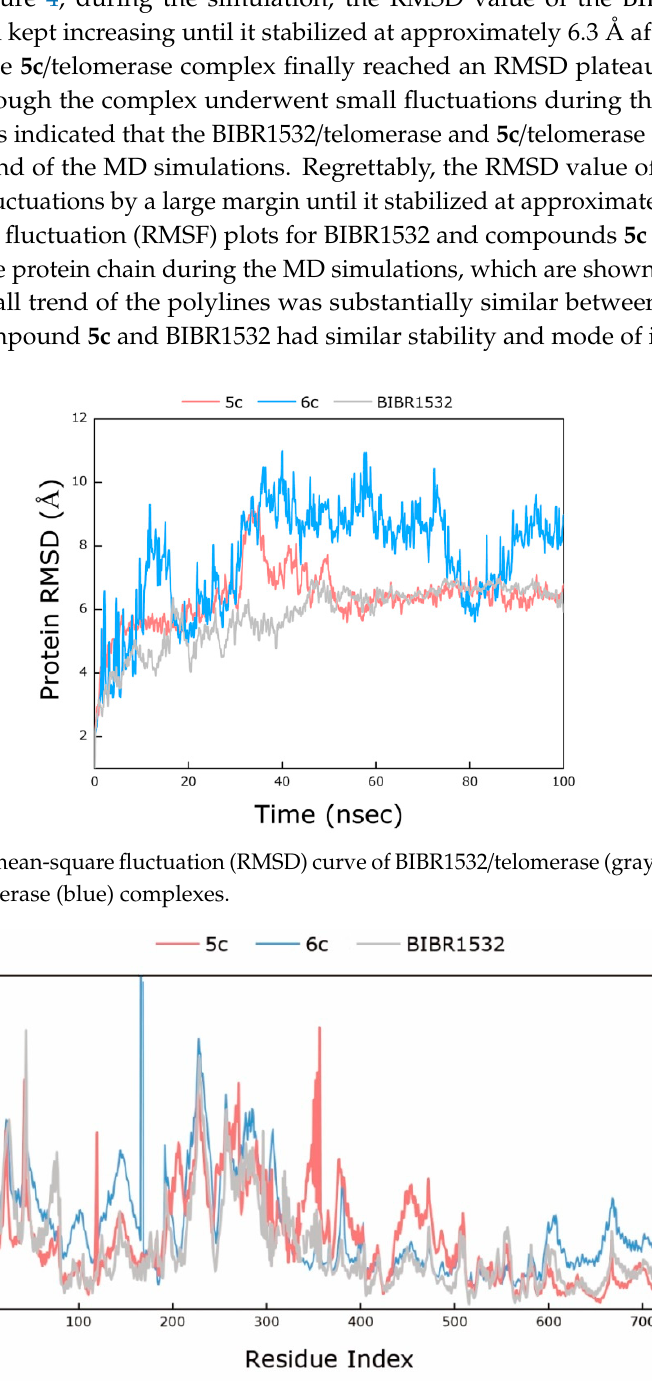
Figure 5. The root-mean-square fluctuation (RMSF) curve of BIBR1532/telomerase (gray), 5c /telomerase (red) and 6c /telomerase (blue) complexes.